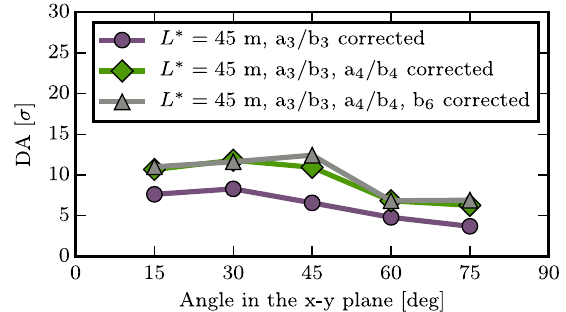
FIG. 18. Minimum dynamic apertures for the IR lattices with L (cid:2) ¼ 36 m ; 45 m, and 61 m with β (cid:2) ¼ 0 . 3 m. The crossing angles were turned off.